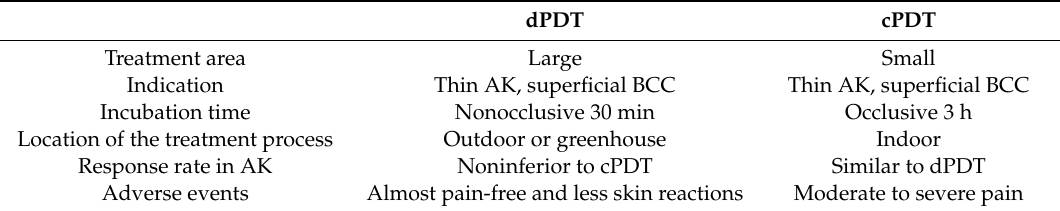
Table 1. Advantages and disadvantages of cPDT versus